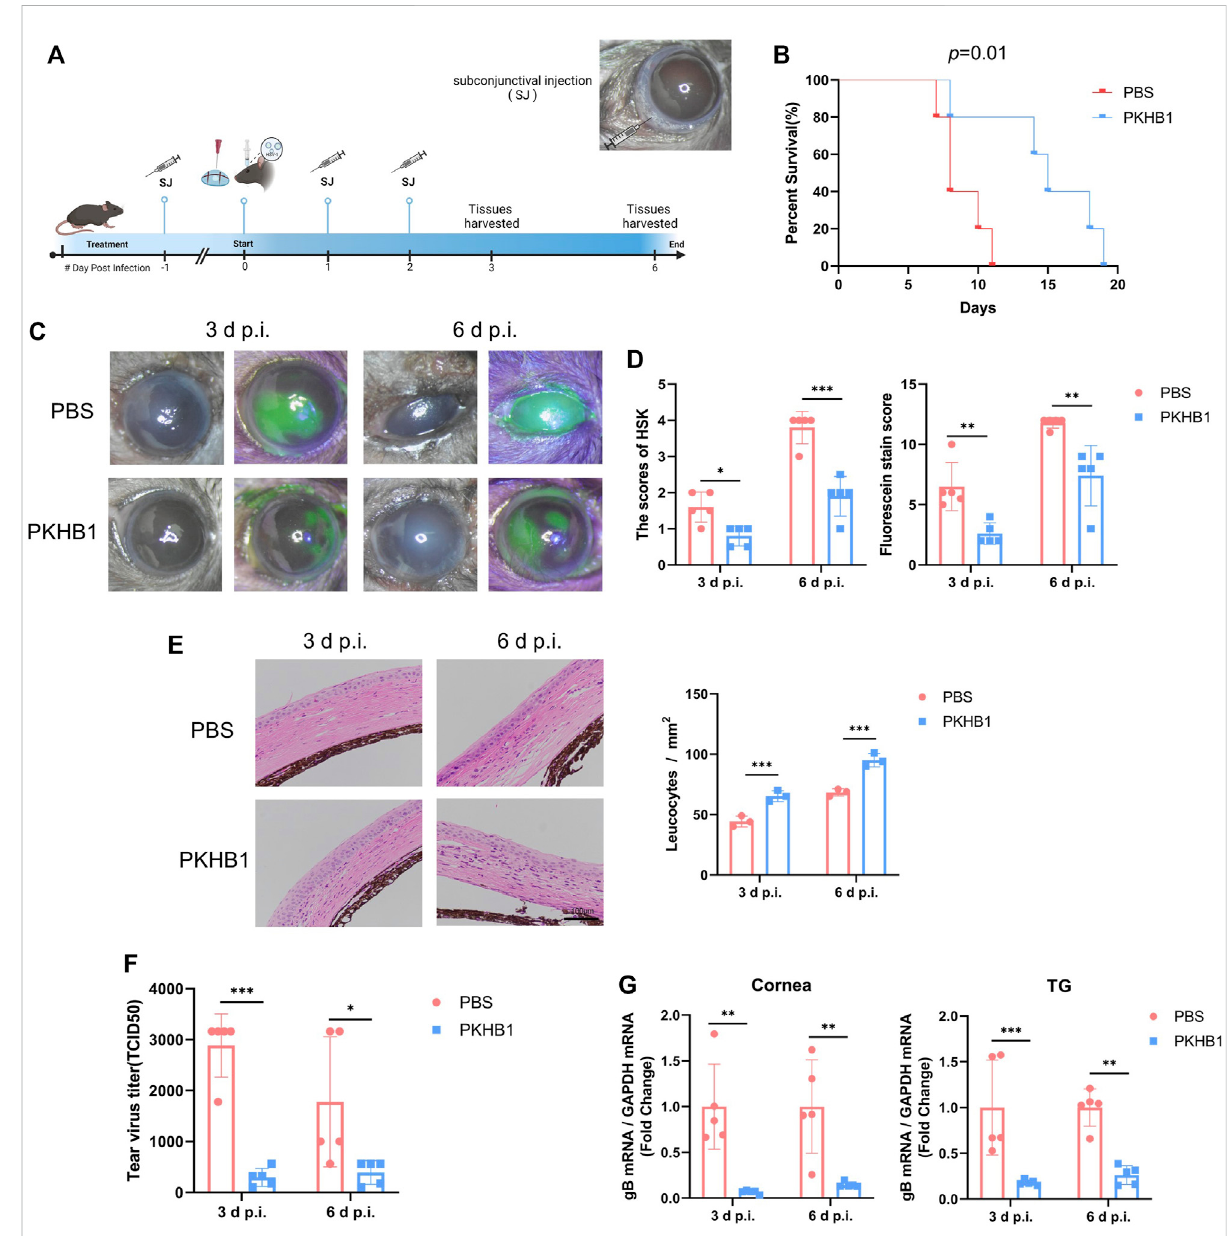
FIGURE 2 Subconjunctival injectionofPKHB1peptide inhibited HSV-1replication andalleviated HSKlesions. (A) Drugdeliveryprocedureandphotograph ofmice eyesafter subconjunctival injection. (B) PKHB1-treatedmice had longer survivalrates. Photographs (C) andscores (D) ofcorneal lesions and sodium fl uorescein staining in mice ( n = 3 – 5). (E) HE staining of mouse corneal sections and quantifying leukocytes in fi ltration. (F) Virus titers of mouse tear swabs were calculated based on the Reed-Muench method. Virus titers of the PKHB1-treated mice were signi fi cantly lower ( n = 5). (G) qRT-PCR was performed to detect the expression levels of HSV-1 gB in mice corneas and TGs at 3 d p.i. and 6 d p.i. ( n = 5), which were signi fi cantlyreducedinthePKHB1-treatedmice.GAPDHwasusedasaninternalreference.Datawerepresentedasmean±SDofthreeindependent experiments. (* p < 0.05, ** p < 0.01, *** p <